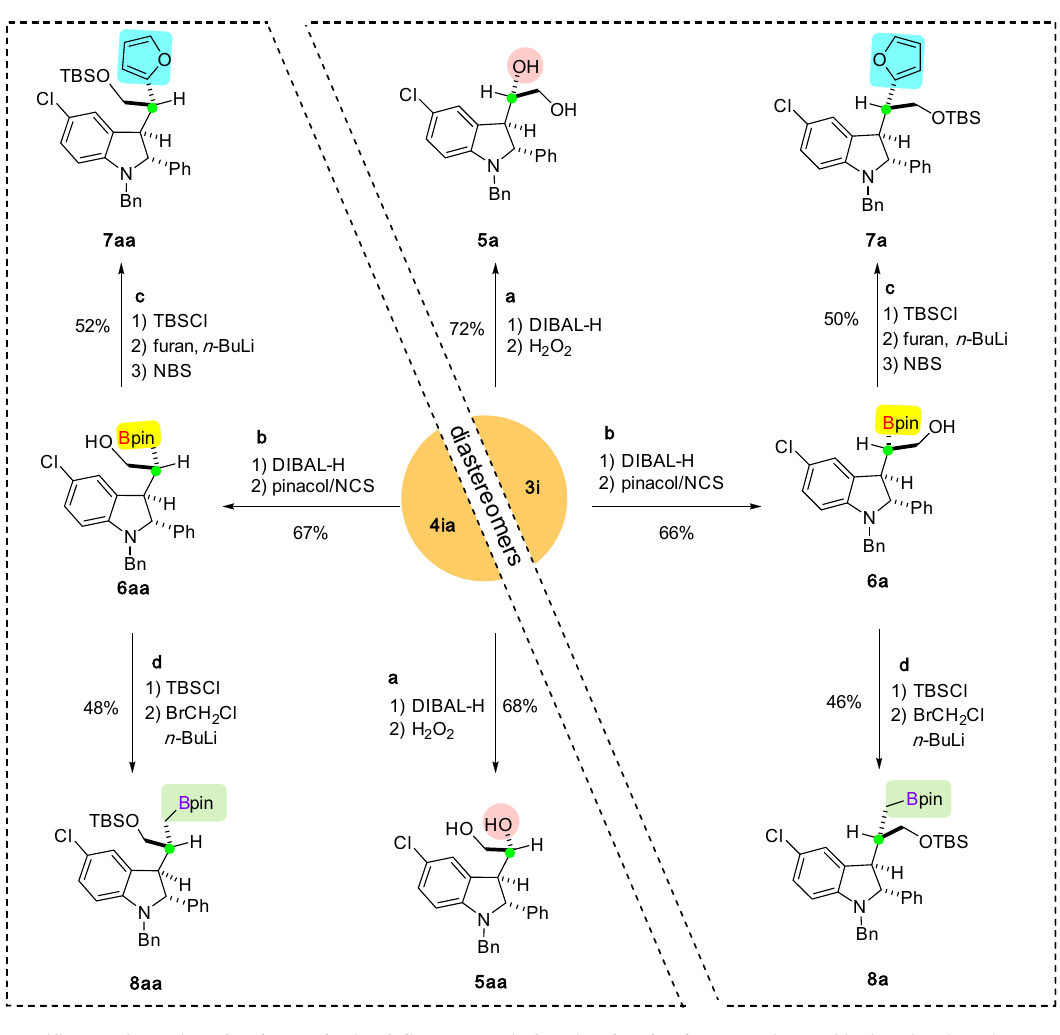
Fig. 4 Stereospeci fi c transformations for the synthesis of diastereomeric functional molecules. a Synthesis of hydroxylated products 5a and 5aa . b Synthesis of pinacol boronic esters 6a and 6aa . c Synthesis of furan-substituted products 7a and 7aa . d Synthesis of homologated pinacol boronic esters 8a and 8aa